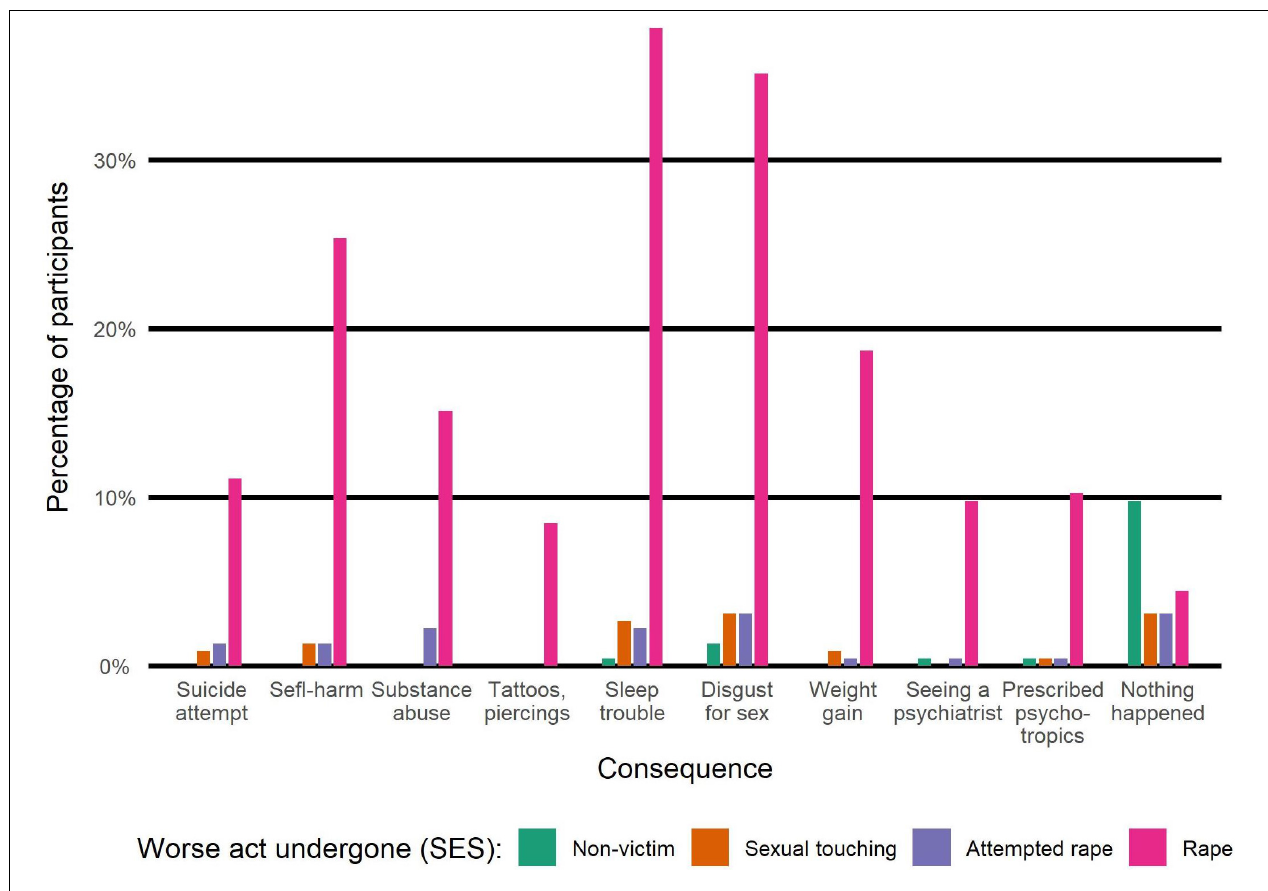
FIGURE 4 | Consequences of assault within 6 months of